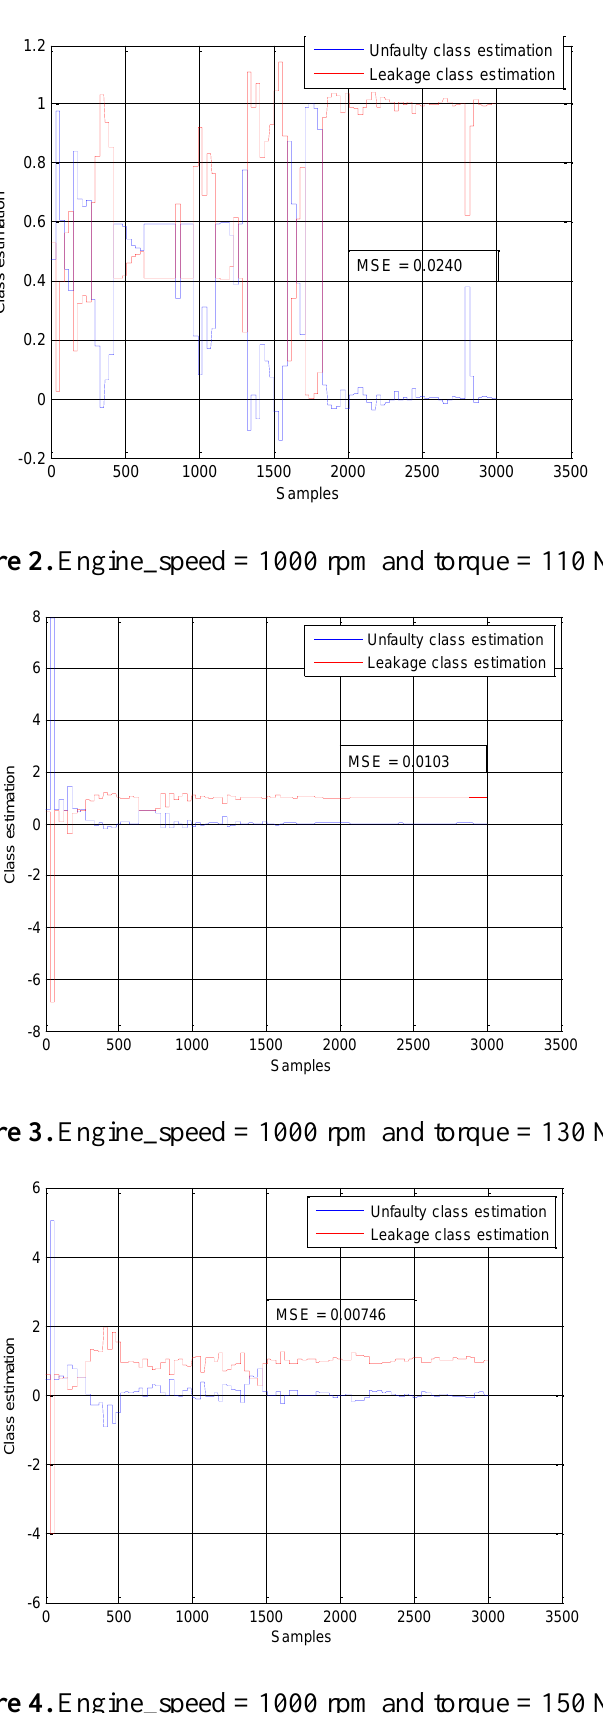
Figure 4. Engine_speed = 1000 rpm and torque = 150